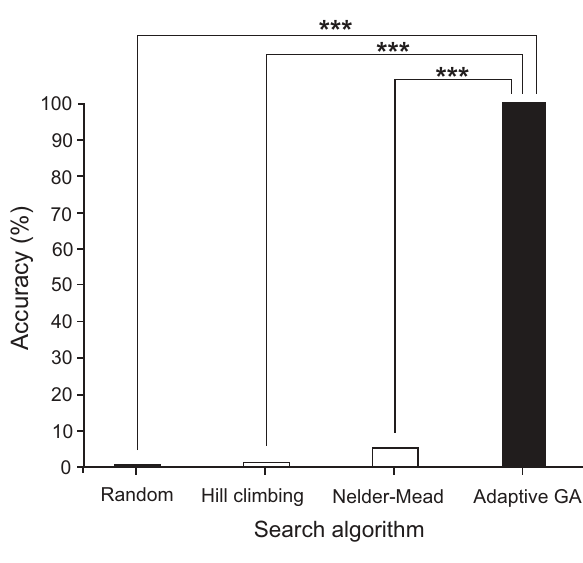
Figure 7. Rastrigin function minimization accuracy results for various search algorithms. Graph of the Rastrigin function minimization problem accuracies among random, Hill climbing, Nelder-Mead, and adaptive GA methods. ***p < 0.001. genetic algorithm (GA).